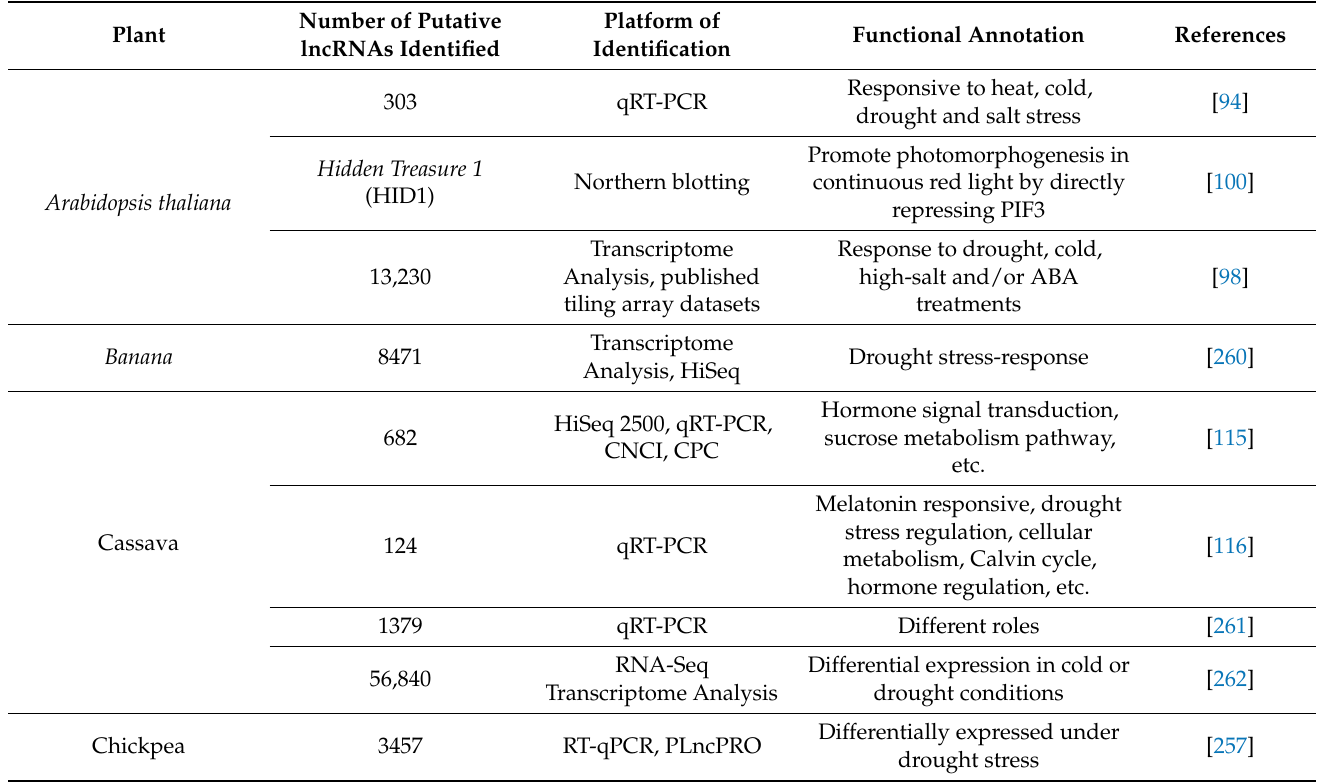
Table 3. Some drought-responsive lncRNAs reported in different